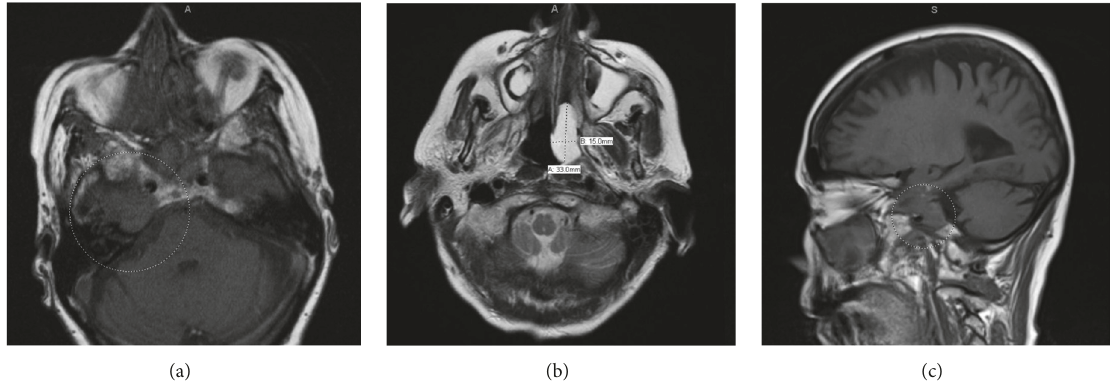
Figure 1: MRI brain: three abnormal bone marrow lesions (left clivus, right clivus, and occipital bone). The right clivus lesion appears to extend to the dura along the medial aspect of the middle cranial fossa which is likely the cause of cranial nerve sixth palsy. (a) Axial section at the level of the pons. (b) Axial section at the level of the medulla. (c) Sagittal section.